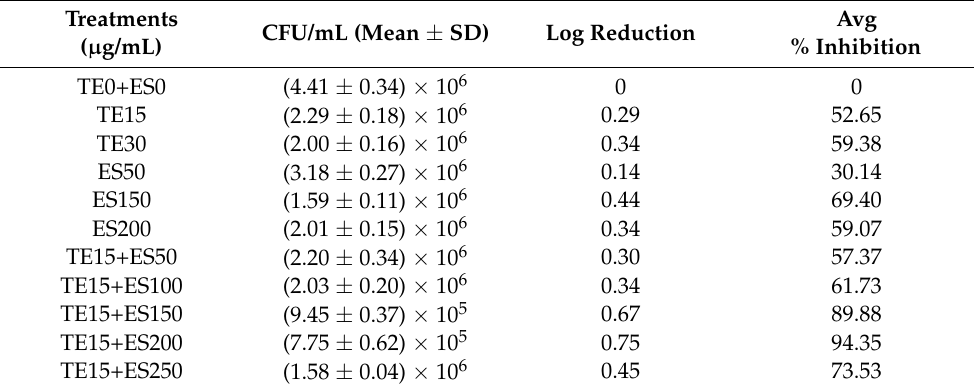
Table 4. Colony-forming units (CFU/mL) and respective log reduction and percentage of inhibition for different treatments on biofilm formation in S. aureus . E: erythromycin; ES: EGCG-S. Treatments